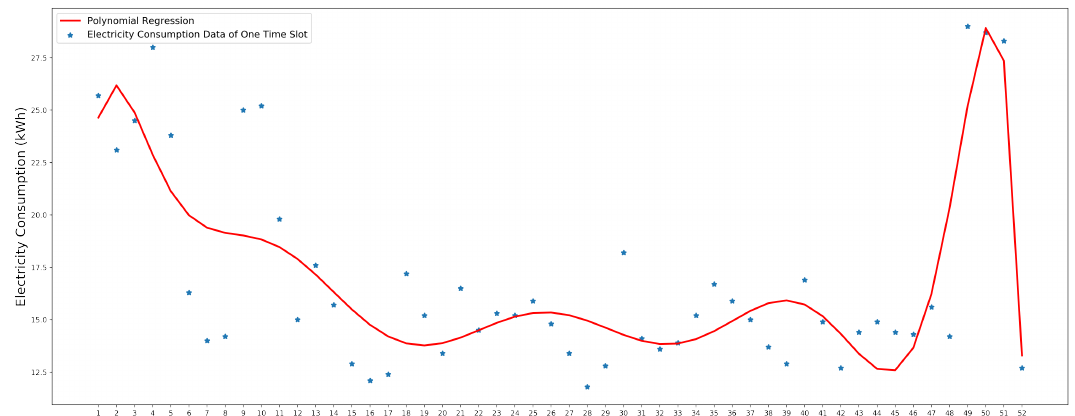
Figure 4. Polynomial regression model fitted to one school’s electricity consumption data for the first time slot through the year 2011. The x -axis is the week number from 1 to 52. The y -axis is the electricity consumption data (kWh). Adapted from [8].